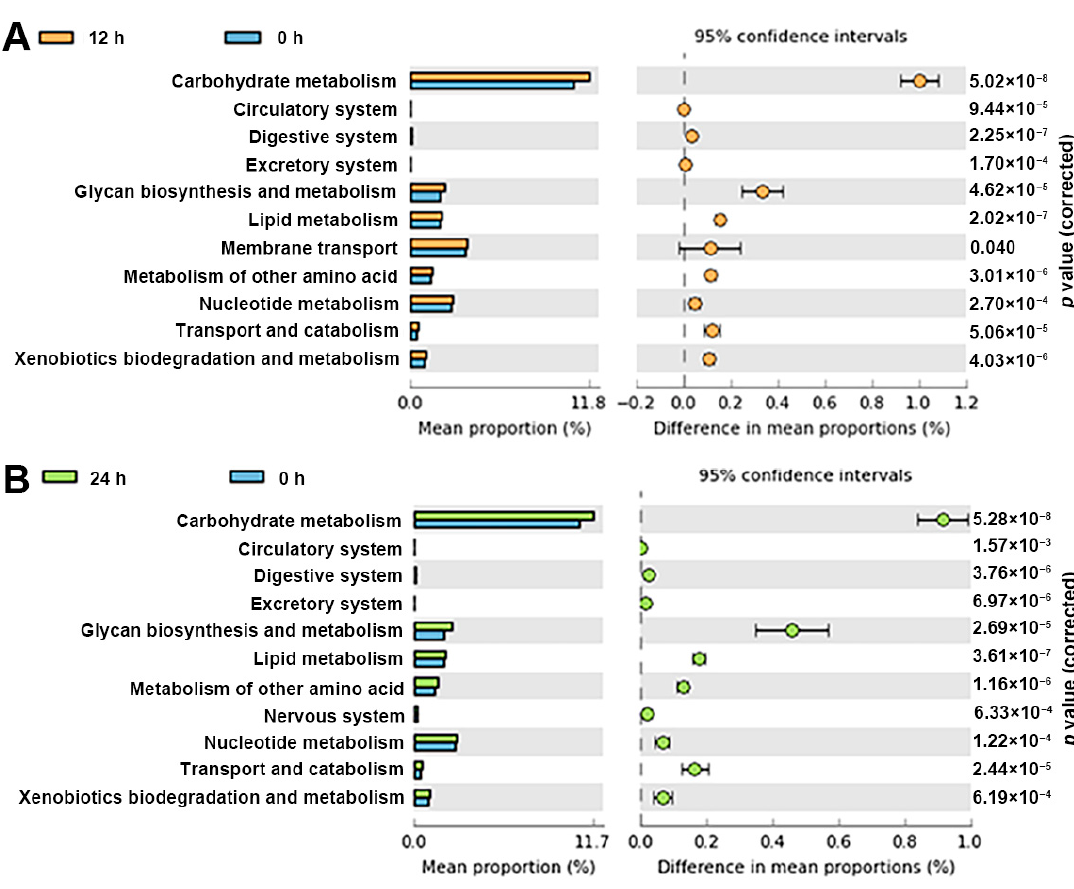
Figure 4. Effects of ABP on the functional profile of the gut microbiota. ( A ) The enriched KEGG pathways in 12 h fermentation at level 2, ( B ) the enriched KEGG pathways in 24 h fermentation at level 2.